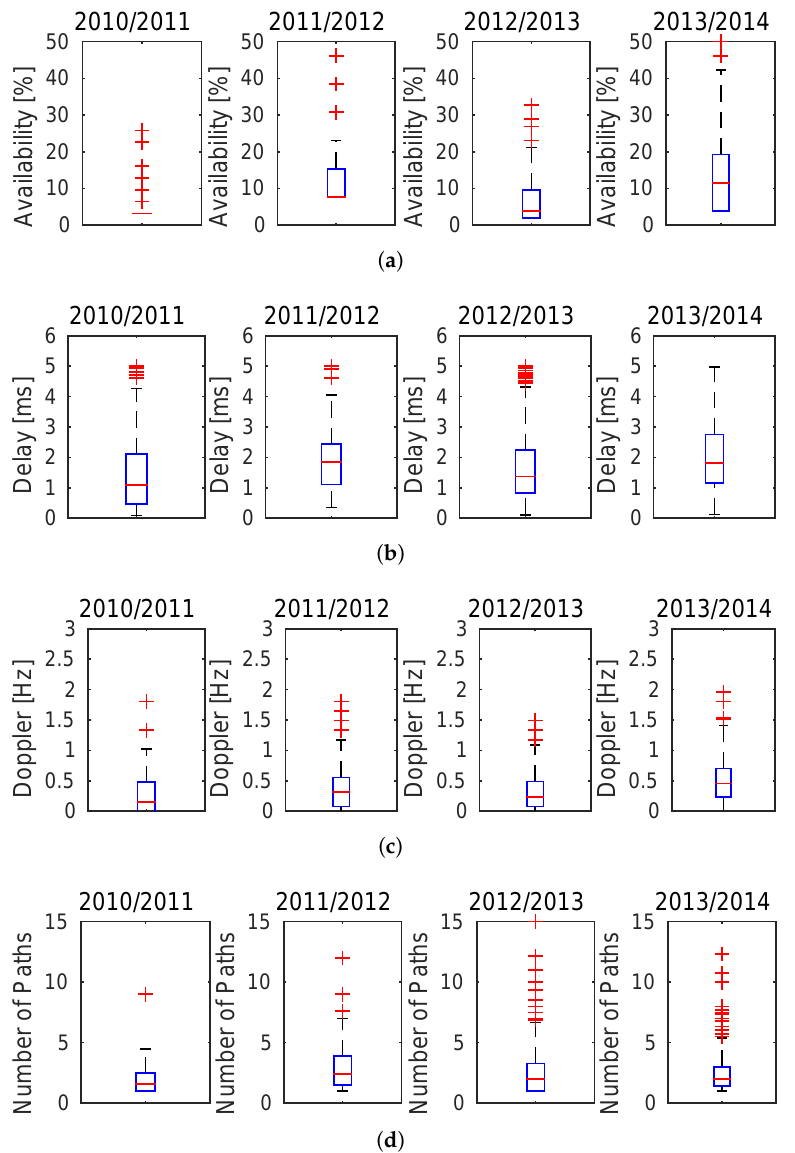
Figure 6. Box and whisker plots of the aggregated results of the four campaigns for the four metrics. ( a ) Availability (%); ( b ) delay spread (ms); ( c ) Doppler spread (Hz); ( d ) number of